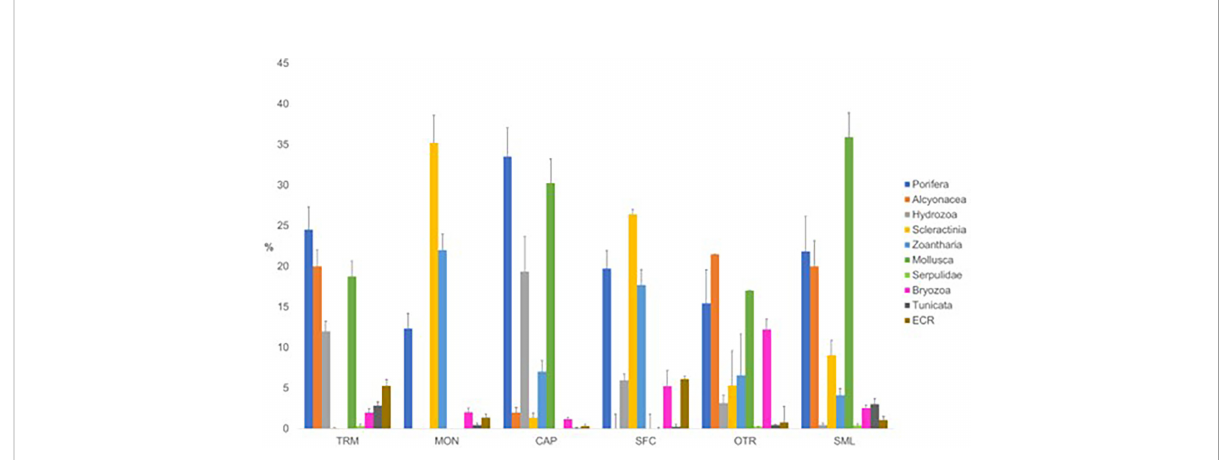
FIGURE 7 Percentage distribution (mean ± St. Dev. of covering values) of the main megabenthic taxa in each investigated area. TRM, Tremiti; MON, Monopoli; CAP, Capitolo; SFC, San Foca; OTR, Otranto; and SML, Santa Maria di